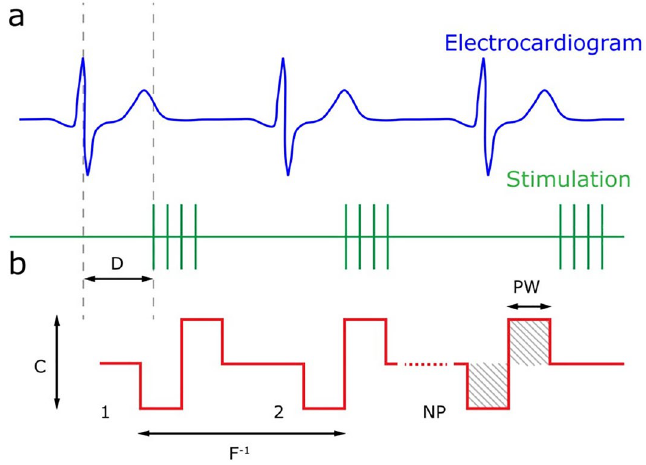
lation pulses were applied in each cardiac cycle with respect to the R-peak of the ECG (Fig. 5a). Cardiac-syn- chronized stimulation may be defined by five main stimulation parameters: current amplitude (C), pulse width (PW), frequency (F), number of pulses (NP), and delay (D). The charge was calculated from the area under the stimulation signal curve (Fig. 5b). The right VN was stimulated for 30 s, followed by 30 s stimulation pause. The general excitability of the VN was assessed through the ability to reduce the HR by 5 bpm. The sensitivity to stimulate was assessed as the charge needed to reduce the HR by 10 bpm. In-vivo, VNS was performed in open-loop, testing different value combinations for the five main stimulation parameters in the ranges specified in Table 1. In the ex-vivo isolated heart, closed-loop stimulation was applied where the current amplitude was adjusted to reduce the error between the measured instantaneous HR and the set HR (reduction by 10 bpm from baseline) while all other stimulation parameters remained constant (Table 1). The initial selection of the stimulation parameter ranges was determined based on a previous work by Ojeda et al., where they presented a novel closed-loop method that allowed an optimized adaption of the stimulation parameters to VNS applications 21 . Selection of parameter ranges was refined from pilot in-vivo experiments that were performed in anesthetized rabbits in our institution. Basically, the upper limits for current, pulse width, etc. were increased from the initial values in order to evoke greater cardiac effects. Further details on the stimulation strategies can be found in Haberbusch et al. 31,34 .